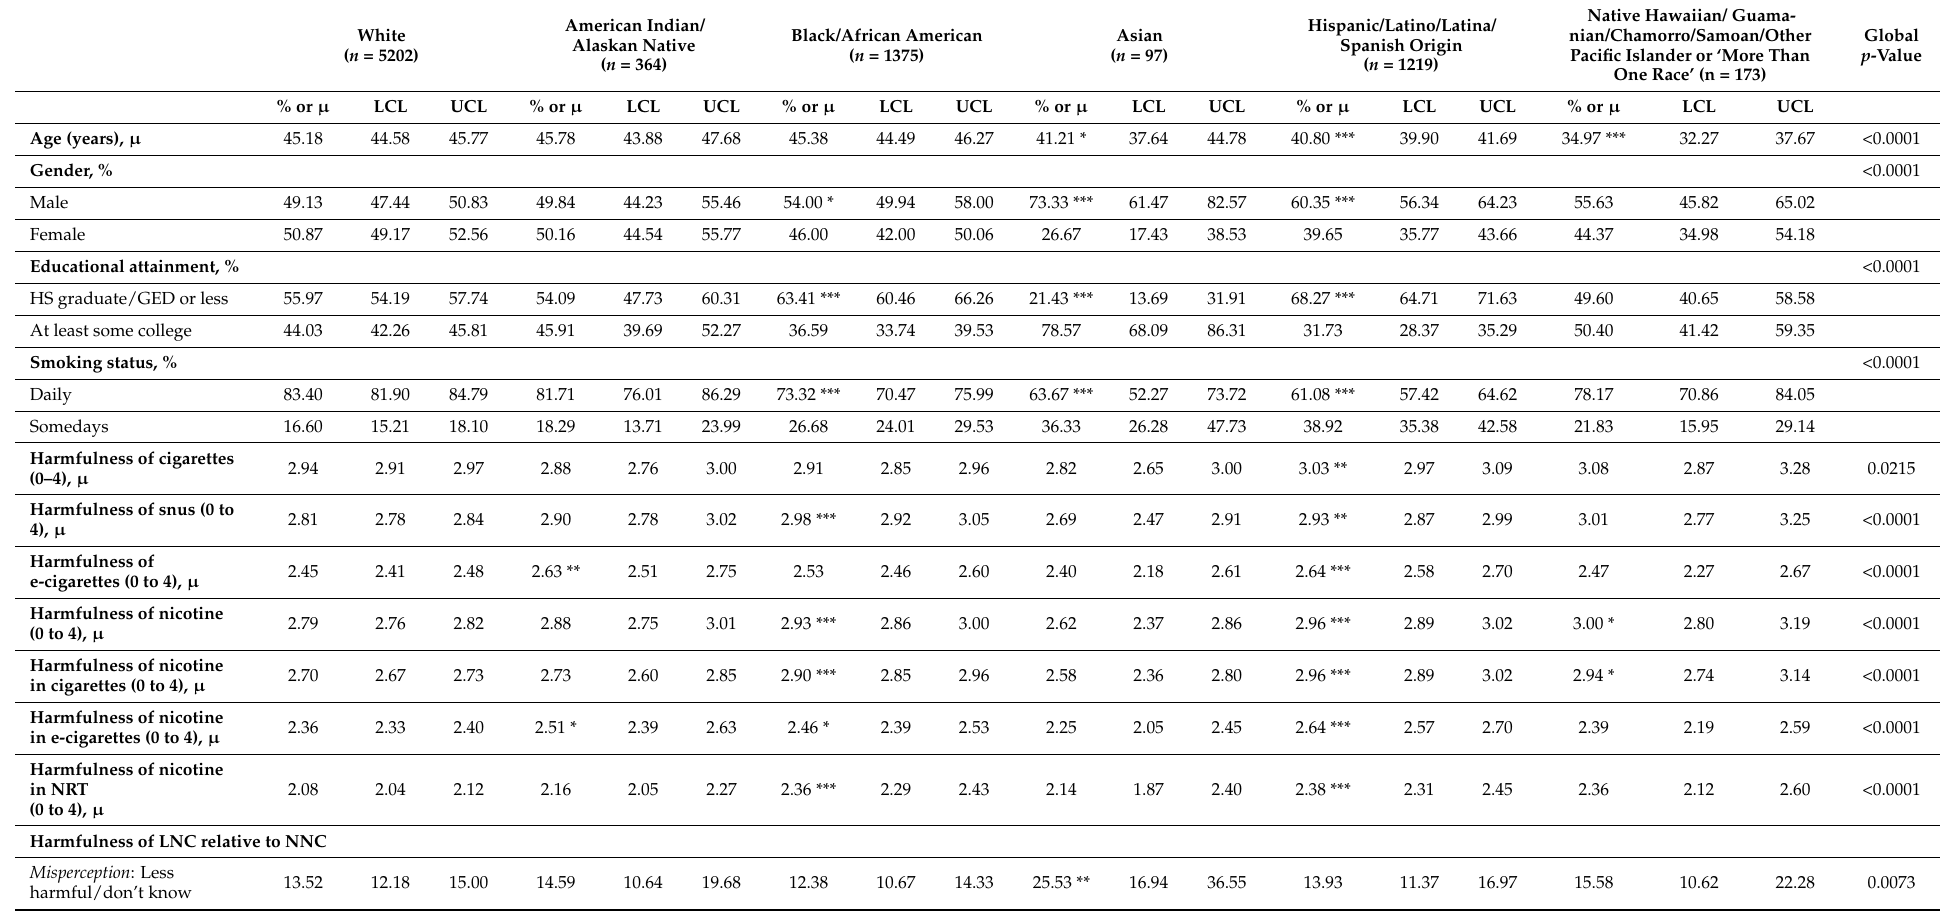
Table 1. Weighted mean values or weighted proportions and corresponding 95% confidence intervals; PATH Wave 4 adults; Current established daily or someday